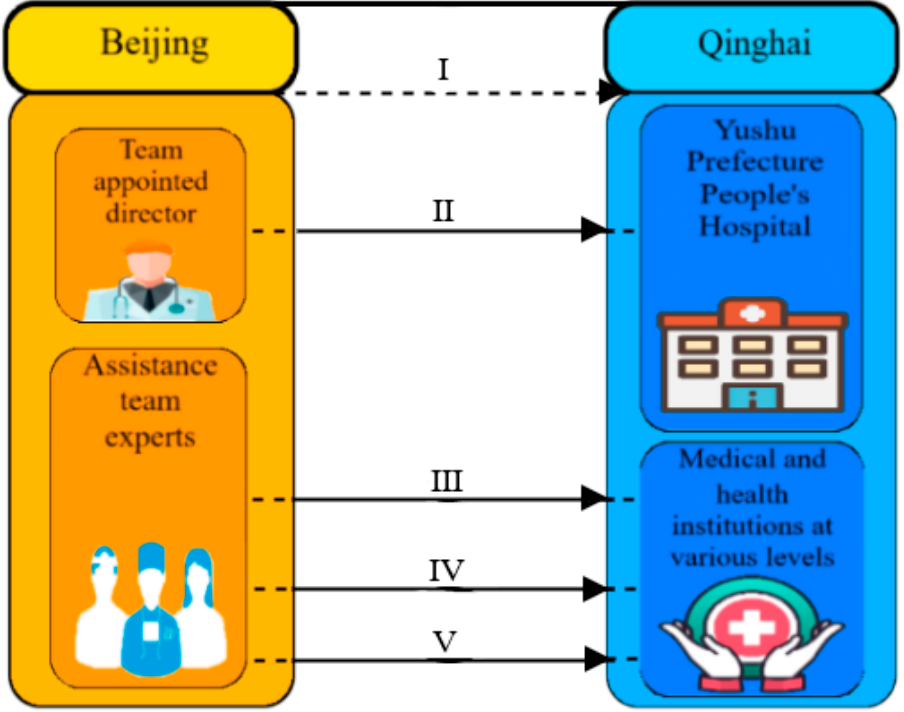
Figure 9. “Dean + Team” medical assistance pattern. Note: I Irregular rotation of medical teams; II Long-term treatment of critically ill patients; III Add new disciplines and opening new wards; IV Train medical assistance team; V Implement medical assistance projects.